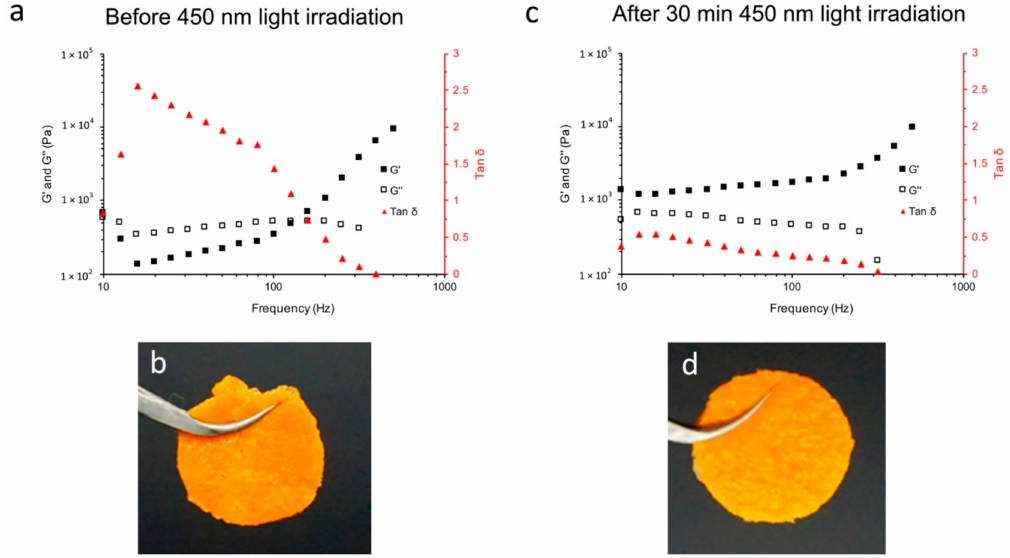
Figure 3. The change in rheological properties of ( a ) the pre-gel of Azo-alginate to the shearing frequency, and ( b ) its image. ( c ) The change in rheological properties of Azo-alginate gel to the shearing frequency, and ( d ) its